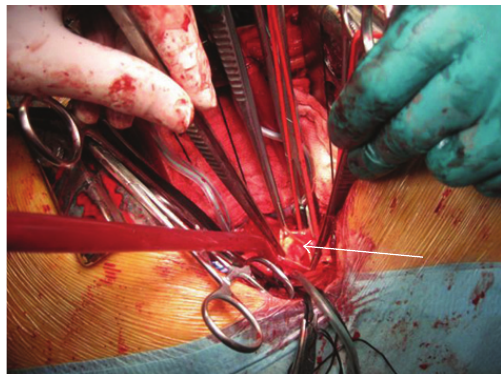
Figure 4: Intraoperative image of the a ff ected thoracic aortic segment with the vegetation ( arrow ).